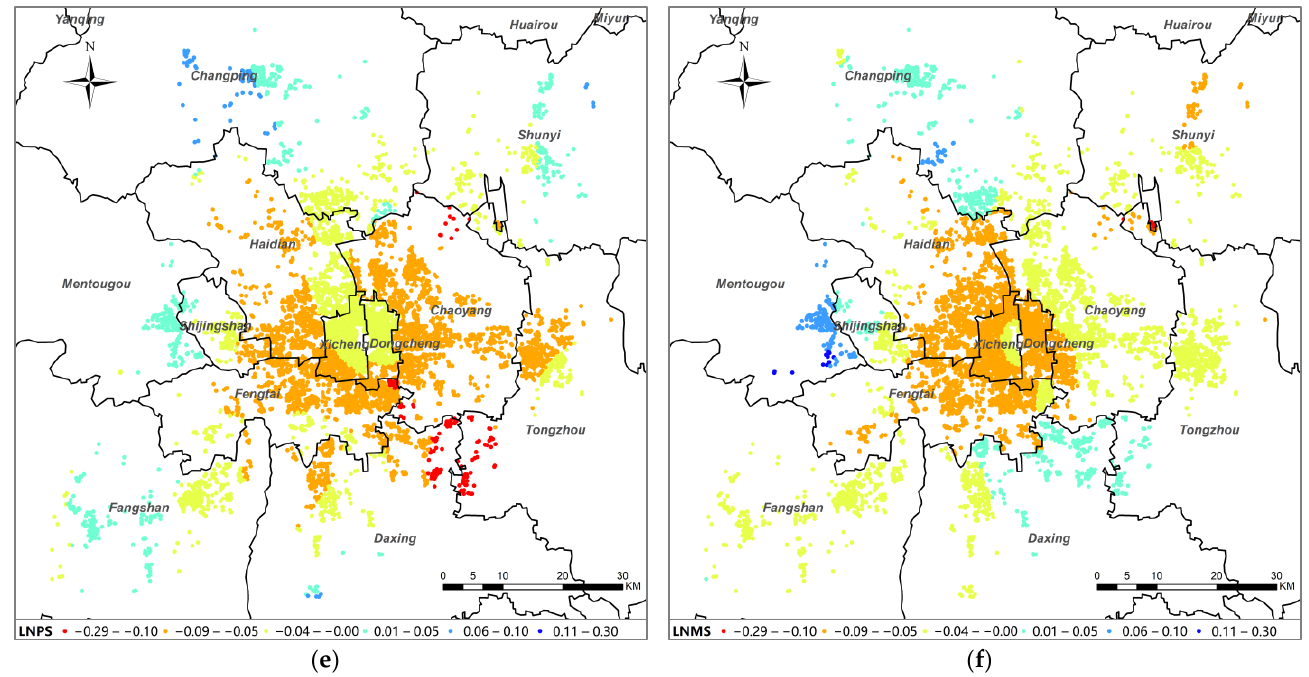
Figure 6. Neighborhood covariate maps of the study area. ( a ) Log of the distance to the nearest subway station (LNS) map of the study area; ( b ) log of the distance to the nearest park (LNP) map of the study area; ( c ) log of the distance to the nearest market (LNM) map of the study area; ( d ) log of the distance to the nearest hospital (LNH) map of the study area; ( e ) log of the distance to the nearest primary school (LNPS) map of the study area; and ( f ) log of the distance to the nearest middle school (LNMS) map of the study area.